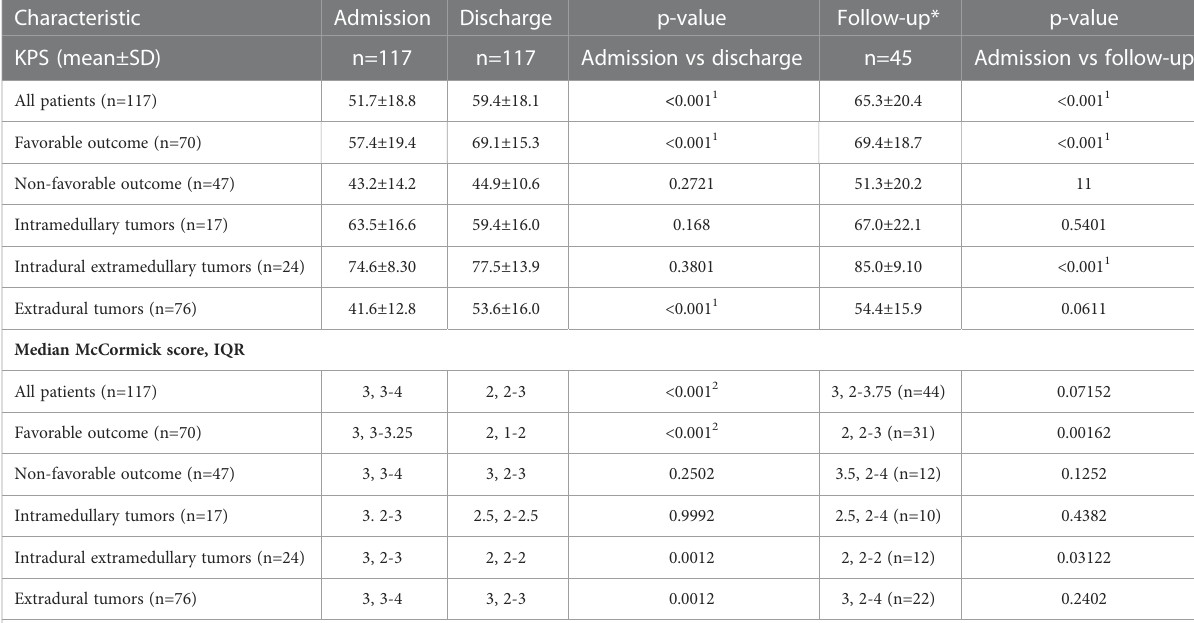
TABLE 4 Comparison of functional parameters at admission vs. discharge or follow-up in patients with favorable outcome, non-favorable outcome, intramedullary, intradural extramedullary and extradural tumors.